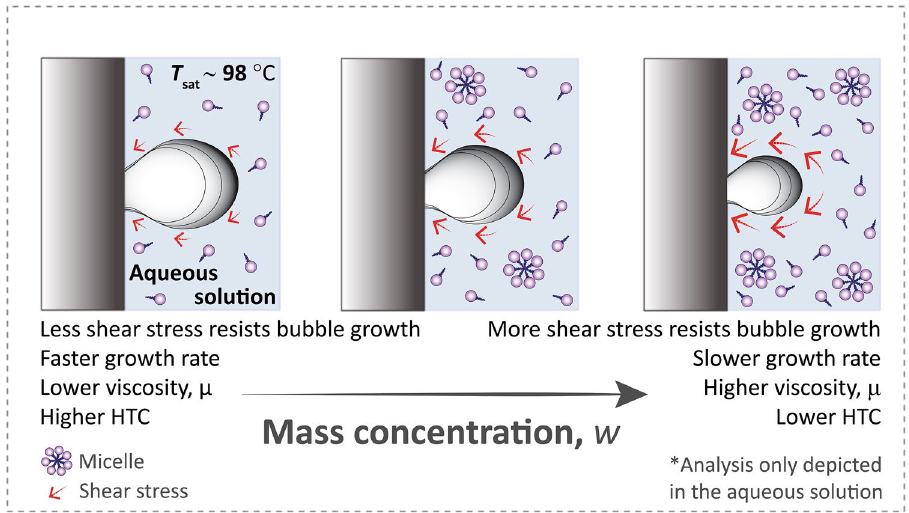
Figure 8. At higher surfactant concentration amounts, the HTC degrades due to increased viscosity resisting bubble growth.